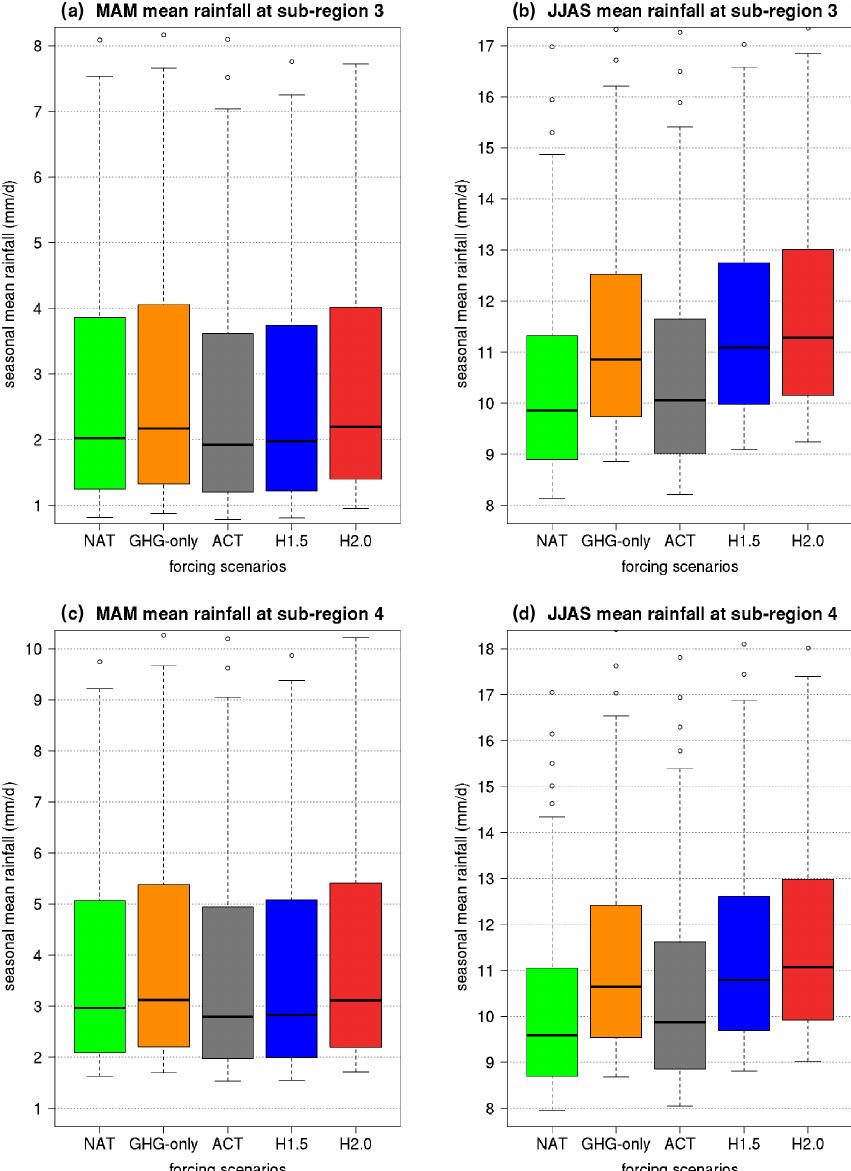
Figure 5. Same as Fig. 4, but for sub-regions 3 and